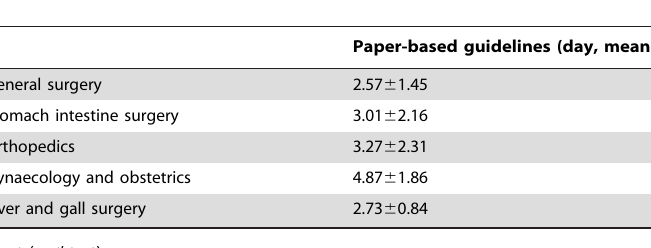
Table 4. The duration of administration in each surgical